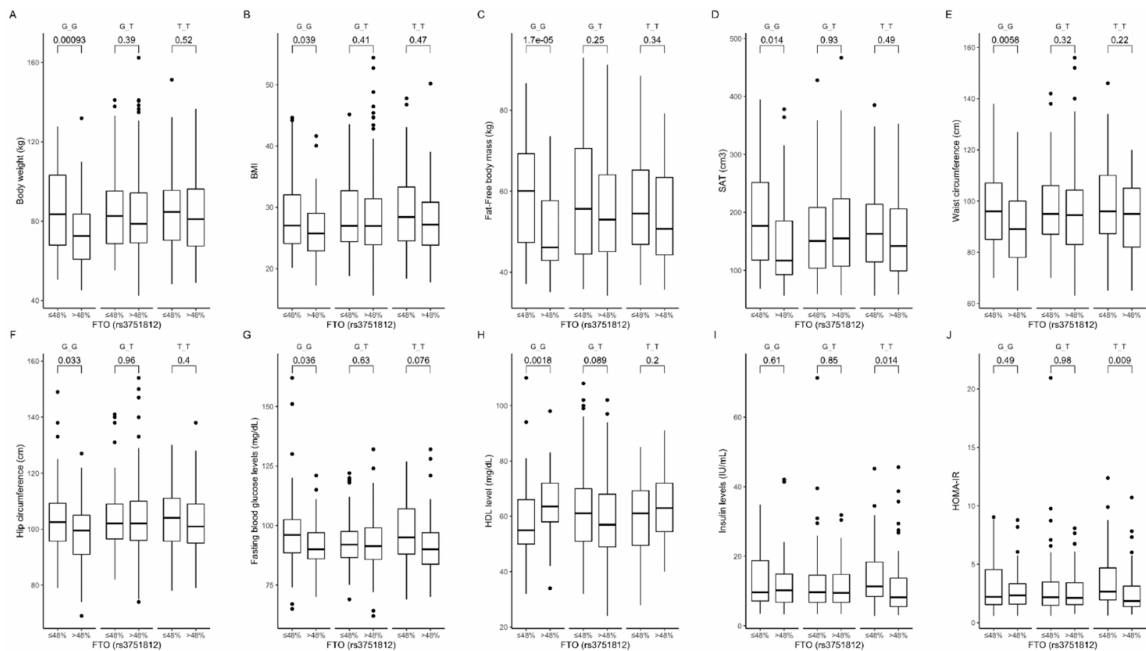
Figure 2. Association of FTO genotypes rs3751812 with ( A ) body weight (kg), ( B ) BMI (kg / m 2 ), ( C ) fat-free body mass (kg), ( D ) subcutaneous adipose tissue (SAT) (cm 3 ), ( E ) waist circumference (cm 3 ), ( F ) hip circumference (cm 3 ), ( G ) fasting blood glucose level (mg / dL), ( H ) HDL level (mg / dL), ( I ) fasting blood insulin level (IU / mL), and ( J ) HOMA-IR by dietary carbohydrate intake strata: ≤ 48% and > 48% of total daily energy intake. HOMA-IR, Homeostatic Model Assessment for Insulin